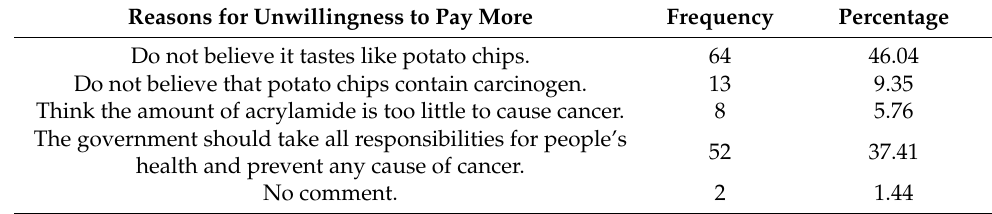
Table 4. Reasonforunwillingnesstopaypremiumpriceonacrylamide-freecassavachipsof139respondents. Reasons for Unwillingness to Pay More Frequency